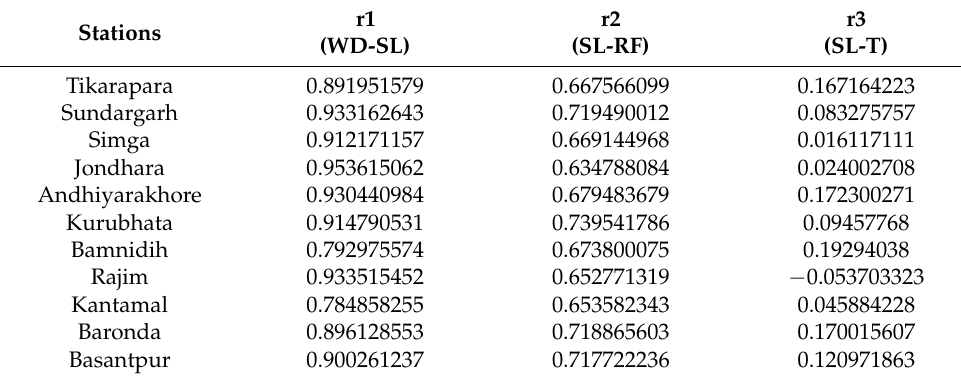
Table 1. Spearman rank correlation coefficient ® of hydro-climatolic data from eleven stations for the